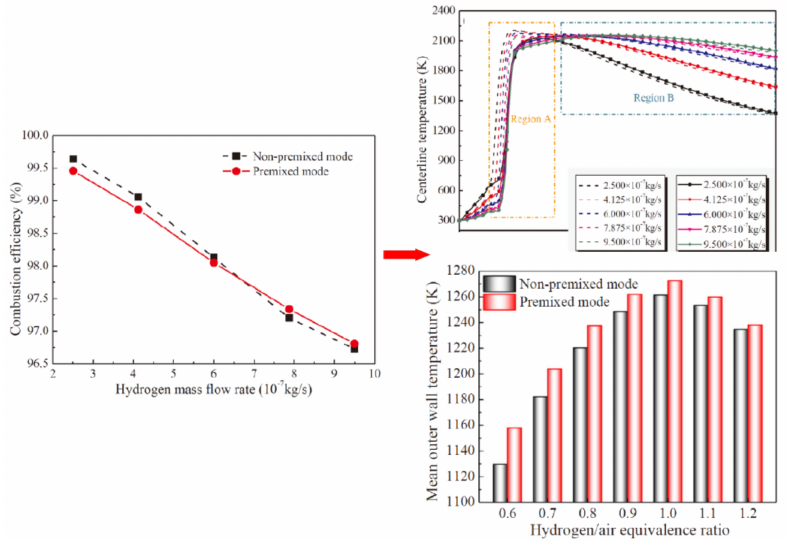
Figure 7. The Centerline temperature and combustion